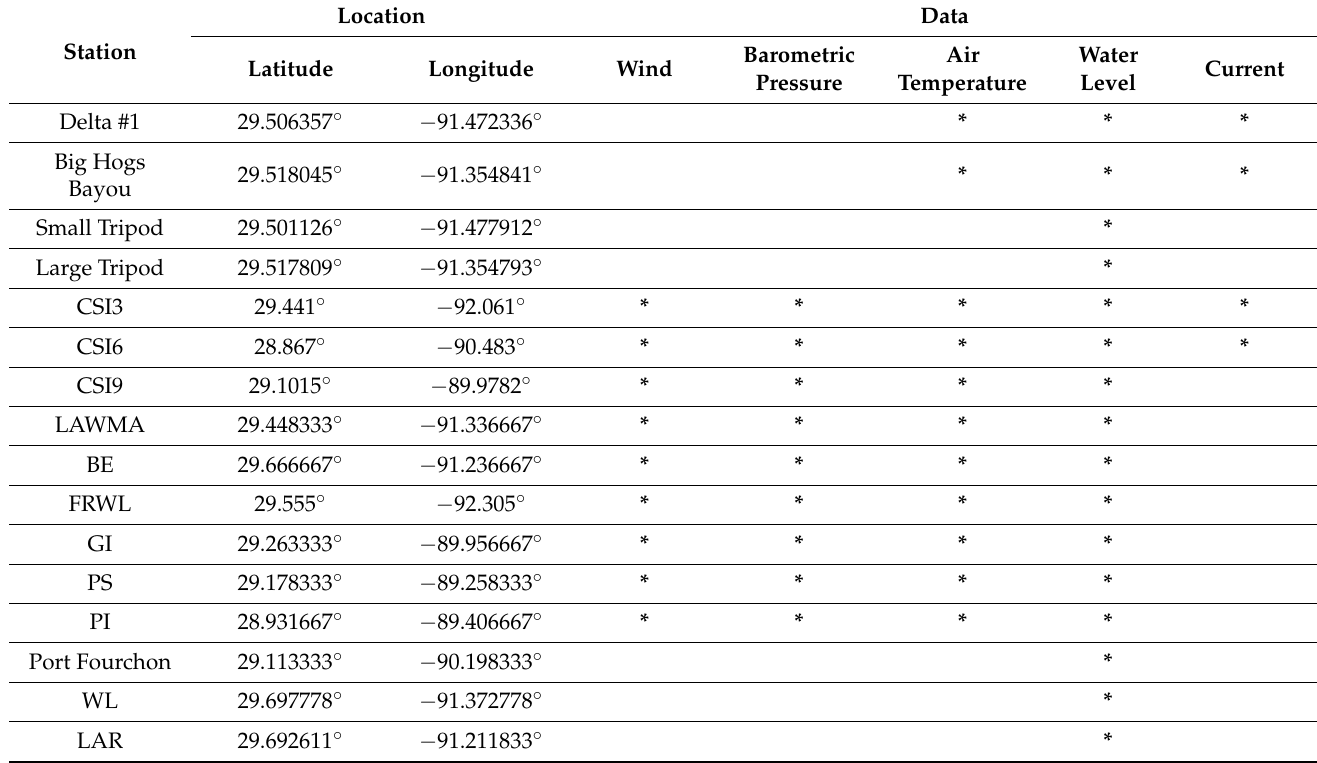
Table 1. Meteorological and oceanographic data from different stations (Figure 1). (* indicates available